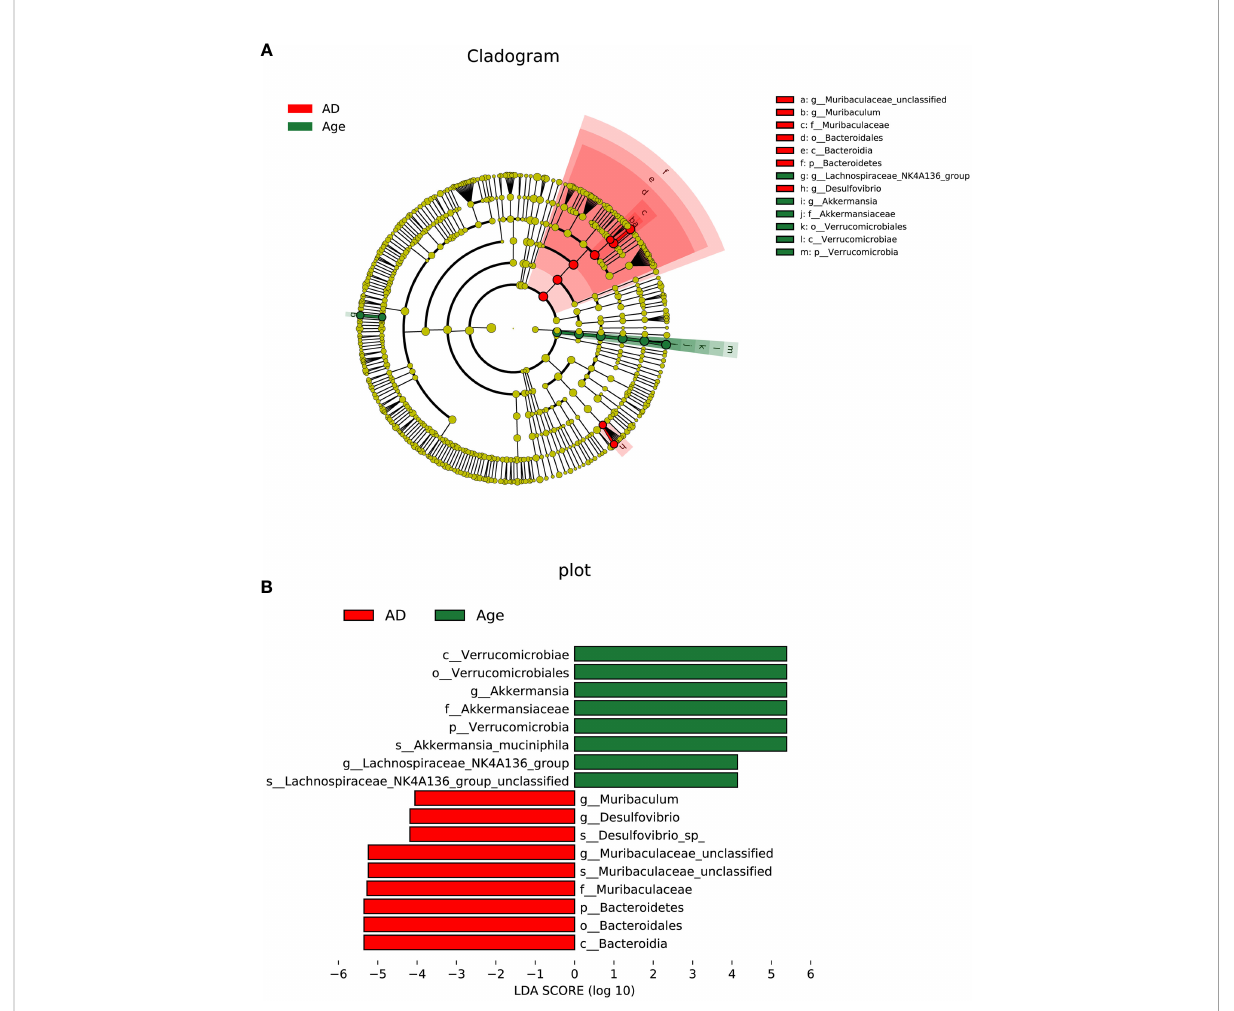
FIGURE 5 Linear discriminant analysis (LDA) integrated with effect size (LEfSe). (A) The circle radiating from inside to outside represents the taxonomic level from phylum to genus, and the species with no signi fi cant difference are yellow. (B) LDA value distribution